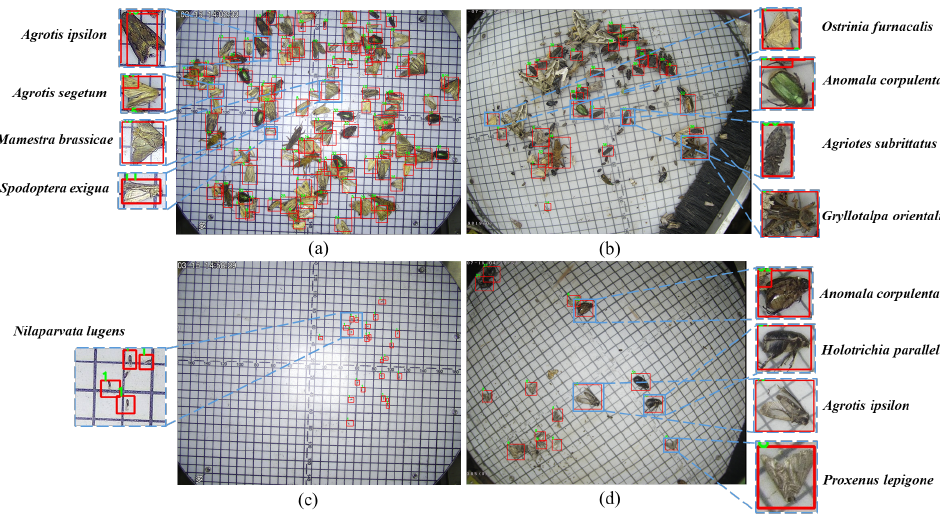
Figure 1. Examples of pest images in the MPD2021 dataset. (Ground truths indicated with the red bounding boxes). ( a ) Example of densely distributed pests. ( b ) Example of complex background image. ( c ) Example of tiny pests. ( d ) Example of normal